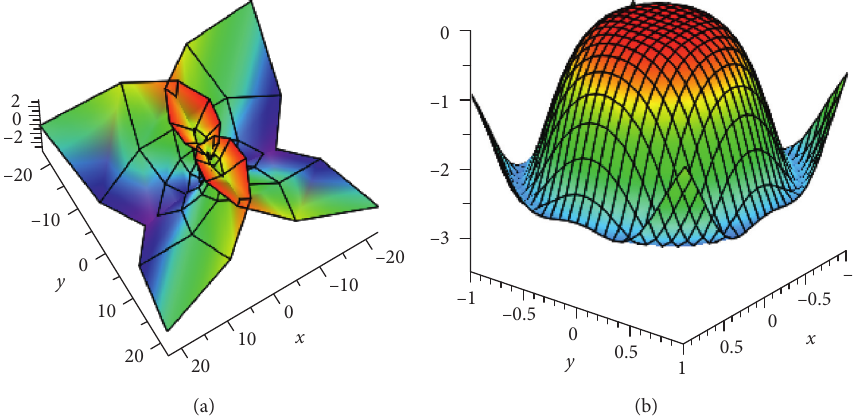
Figure 1: (a) Enneper fifth-order surface in the interval x ∈ [− 1 . 2 , 1 . 2 ] , y ∈ [− 1 . 2 , 1 . 2 ] ; (b) soliton deformation of inverted Enneper fifth- order surface at the point of origin for nonzero parameters a,b, c .